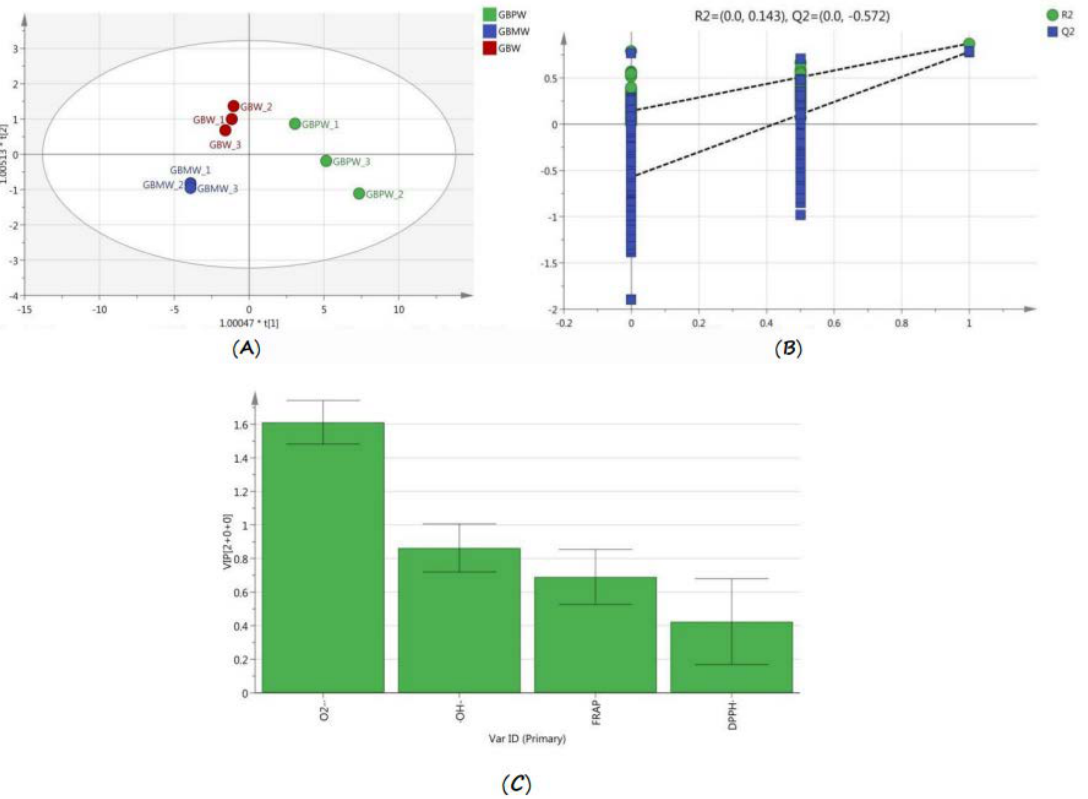
Figure 5. OPLS-DA model of antioxidant activities of green banana wine samples. ( A ) OPLS-DA score plot, ( B ) permutation tests for the OPLS-DA model, and ( C ) column plot of the variable average intensity of the four in vitro antioxidant activity assays.